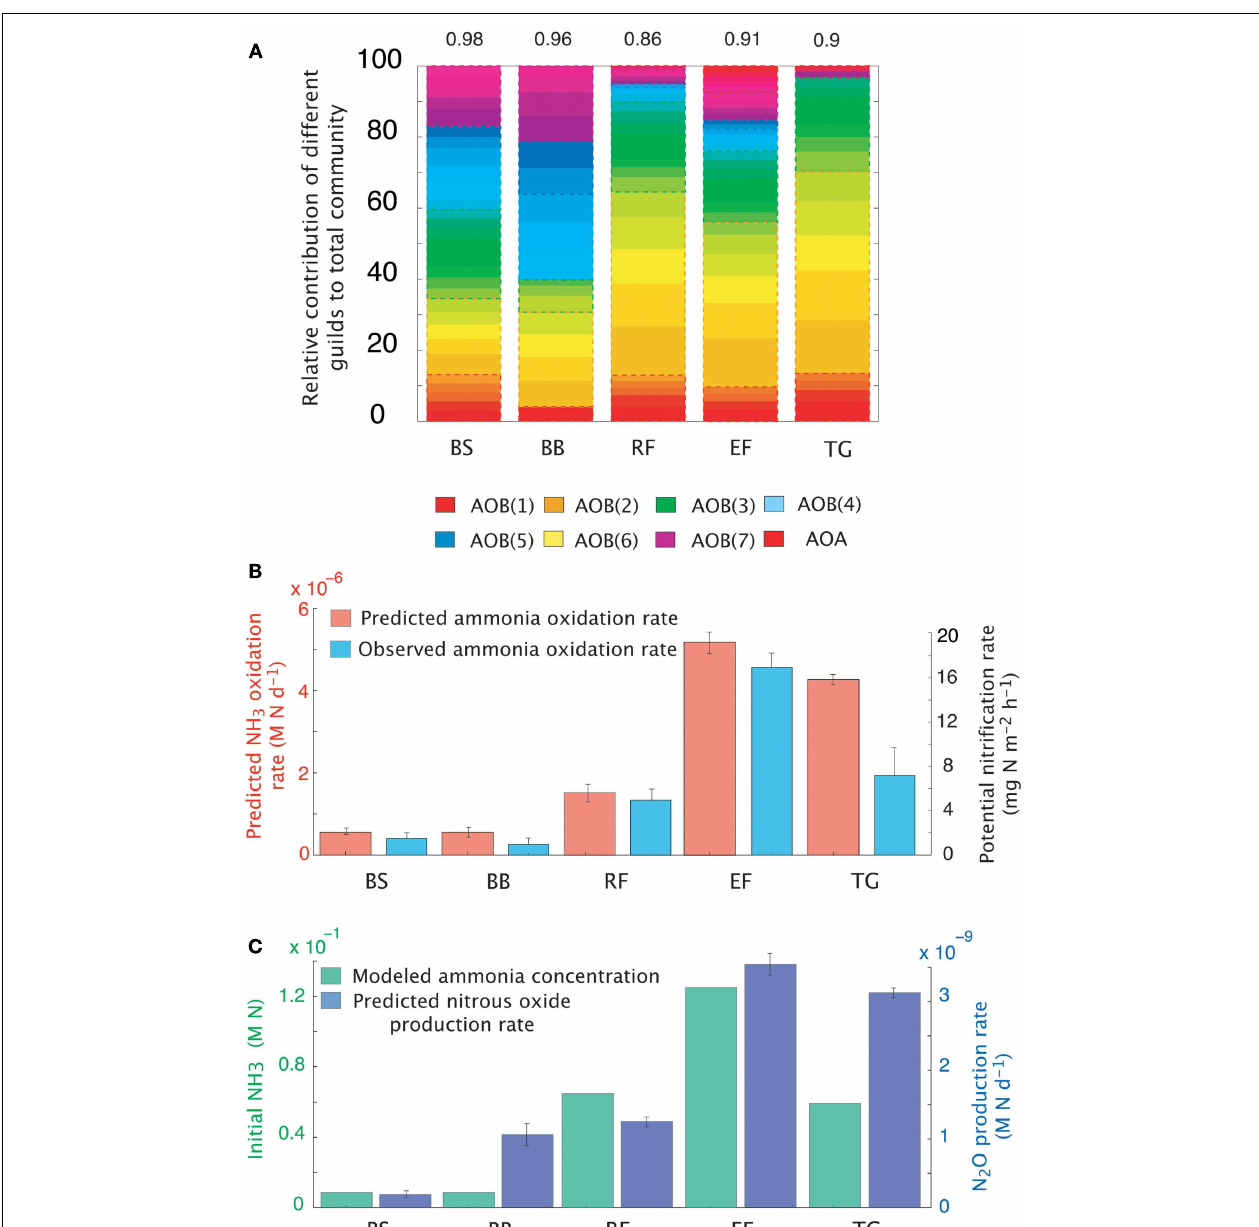
guild’s biomass. Evenness statistic given above the bar plots. (B) NH 3 oxidation rates from just simulated and observed data. (C) Predicted rates of N 2 O production and measured NH 3 concentrations. Error bars are the result of multiple simulations ( n = 3). BS, Black Spruce; BB, Bog Birch; RF, Rich Fen; EF, Emergent Fen;TG,Tussock